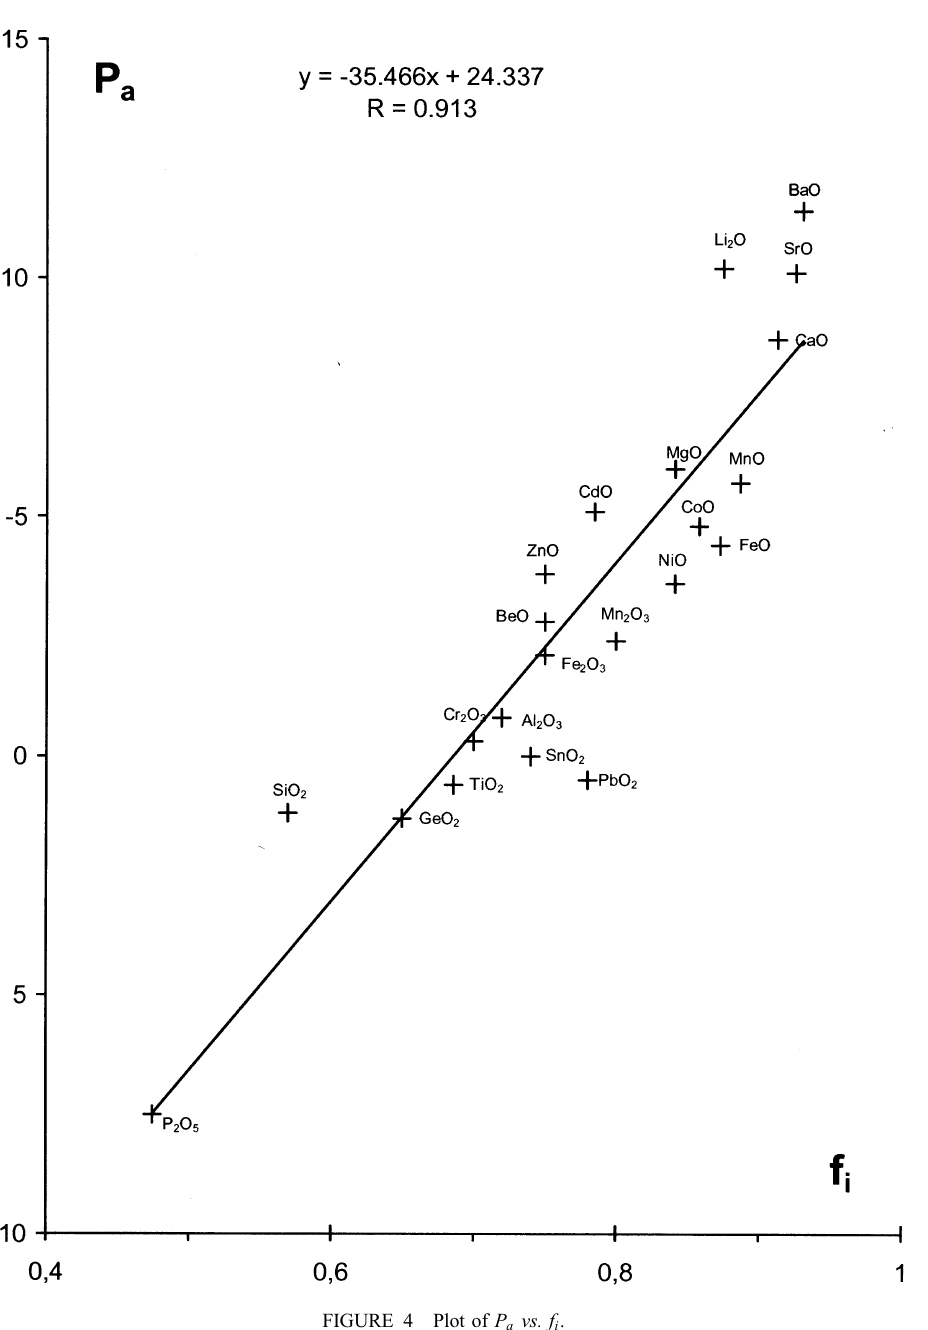
FIGURE 4 Plot of P a vs. f i